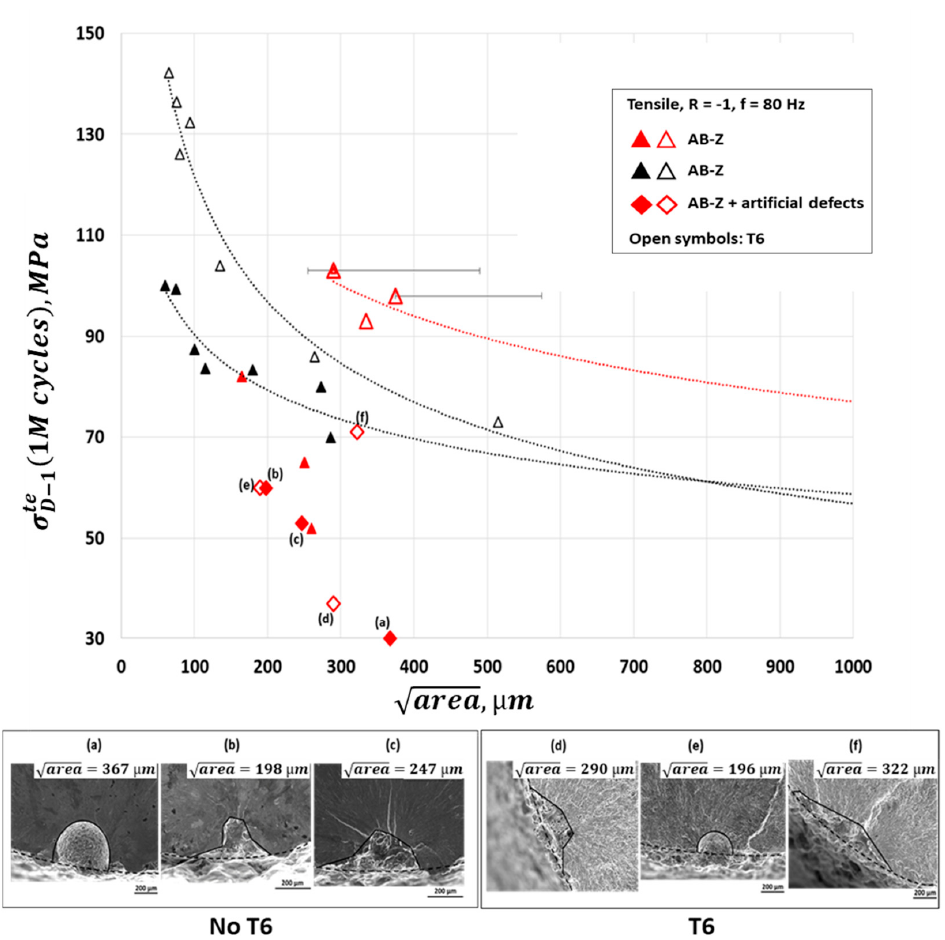
Figure 12. Kitagawa-type diagram showing the impact of defect size and morphology on the fatigue limit of as-built surfaces compared with machined samples in the Z building direction.